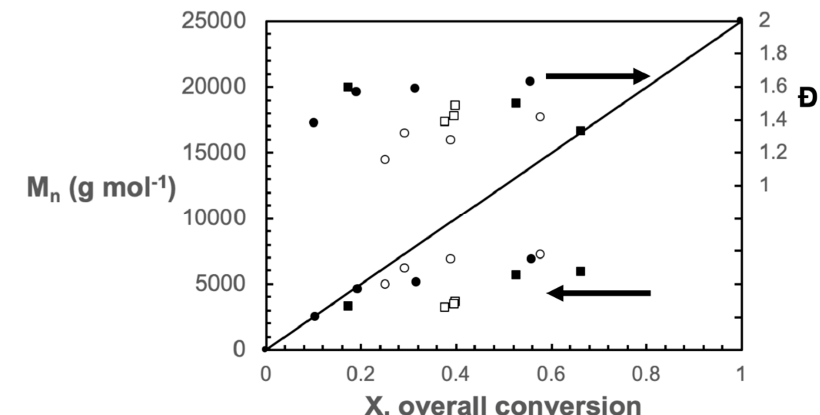
Figure7. NumberaveragemolecularweightM n versusoverallconversion(X)forDBI / Scopolymerization Figure 7. Number average molecular weight M n versus overall conversion (X) for DBI/S with initial DBI feed compositions f DBI,0 = 0.60–0.90 done at 70 ◦ C: f DBI,0 = 0.6 (filled circles, (cid:8) ); f DBI,0 = 0.7 copolymerization with initial DBI feed compositions f DBI,0 = 0.60–0.90 done at 70 °C: f DBI,0 = 0.6 (filled (open circles, ); f DBI,0 = 0.8 (filled squares, (cid:4) ), f DBI,0 = 0.9 (open squares, (cid:3) circles,  ); f DBI,0 = 0.7 (open circles,  ); f DBI,0 = 0.8 (filled squares,  ), f DBI,0 = 0.9 (open squares,  ). (cid:35)